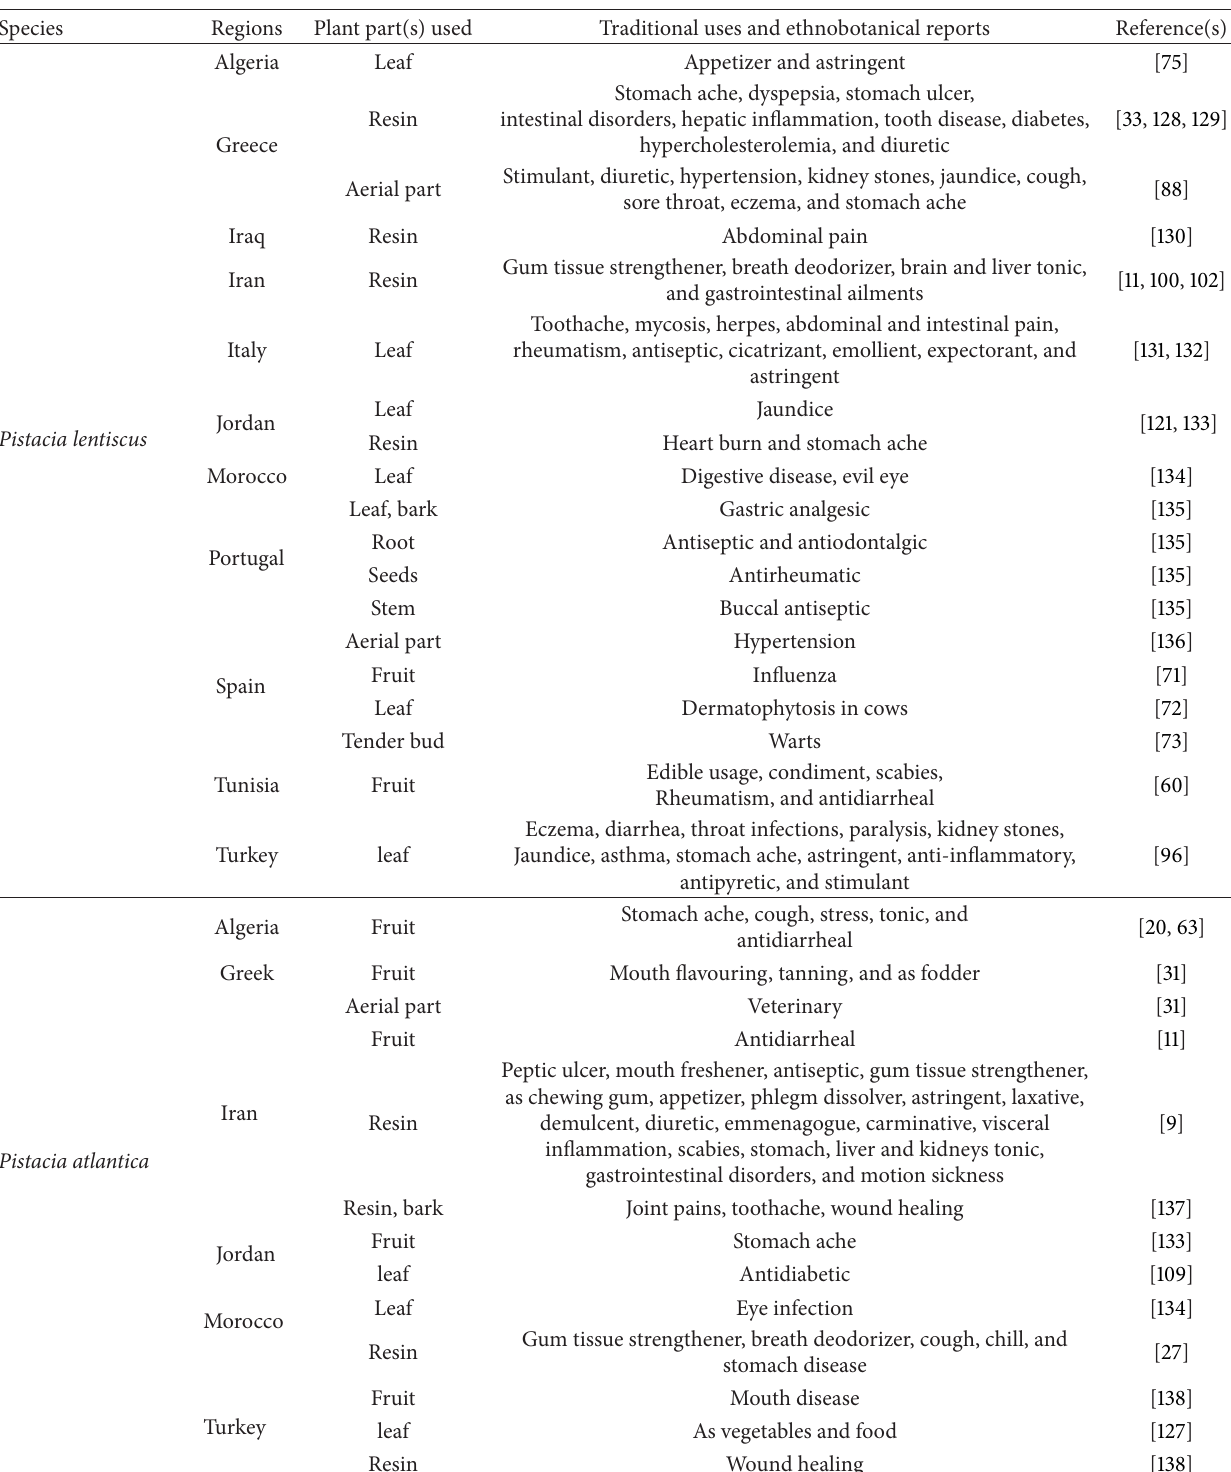
Table 1: Ethnomedicinal uses of selected Pistacia